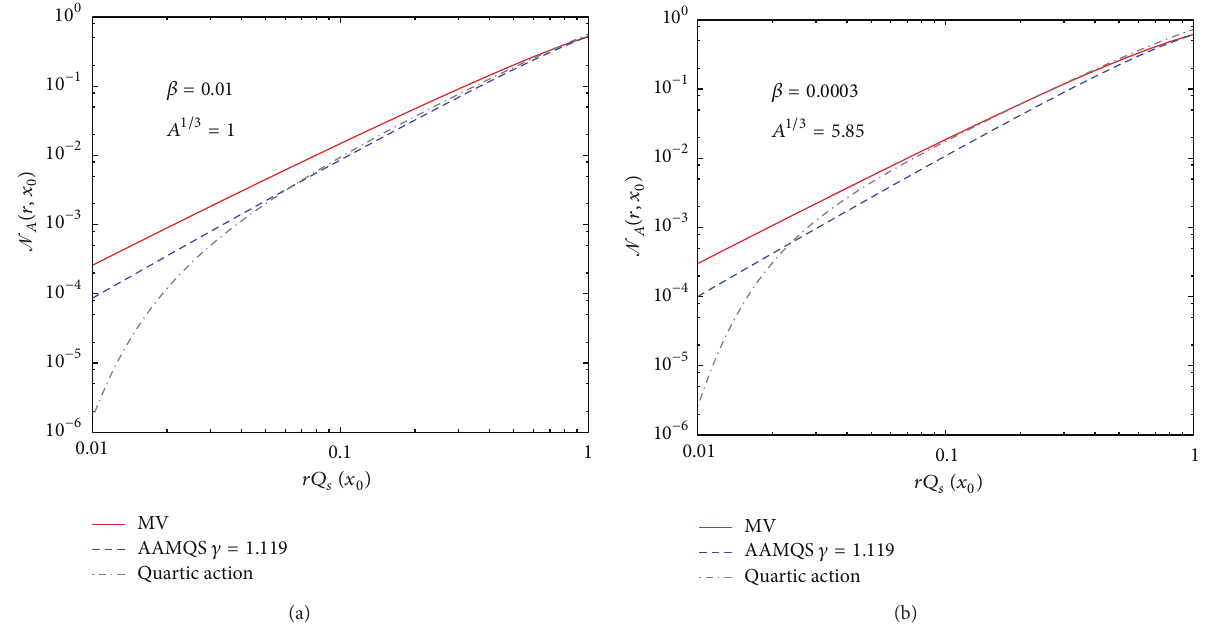
Figure 1: (a) Dependence of dipole scattering amplitude in an adjoint representation ( N 𝐴 = 2 N 𝐹 − N 2 𝐹 ) on 𝑟𝑄 𝑠 (𝑥 0 ) with three different models indicated in the figure. (a) is for a proton target assuming 𝑄 2 𝑠 = 0.168 GeV 2 and Λ 2 = 0.058 GeV 2 . (b) is for a nucleus target with 𝐴 = 200 (which is between Au and Pb), 𝑄 2 ∼ 𝐴 1/3 , and 𝛽 ∼ 𝐴 −2/3 (or 𝛽 = 0.0003 𝐴 𝑠